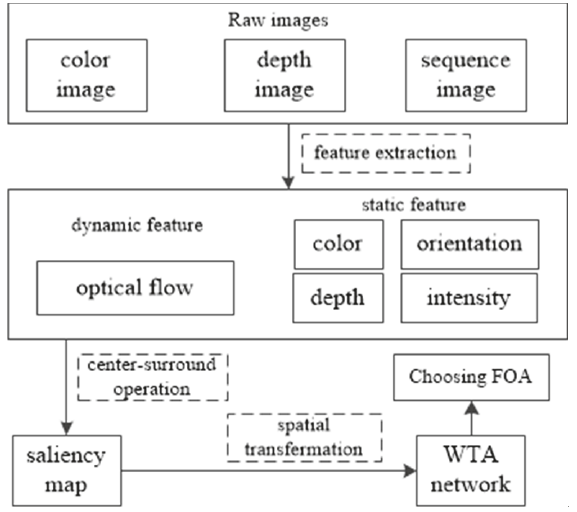
Figure 2: Illustration of selective attention model procedure.